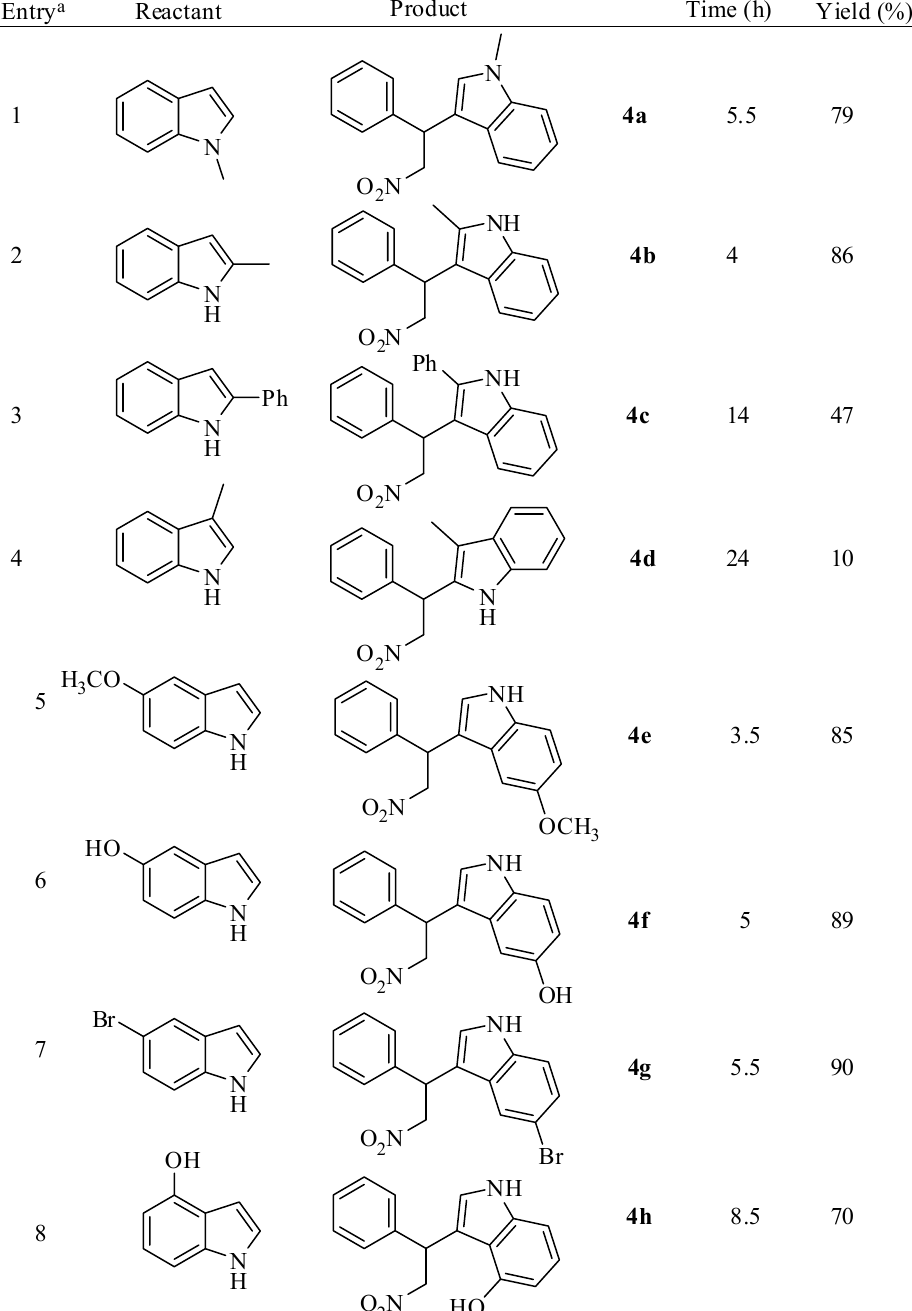
Synthesis of aryl-nitroalkane derivatives from various indoles and other heterocyclic